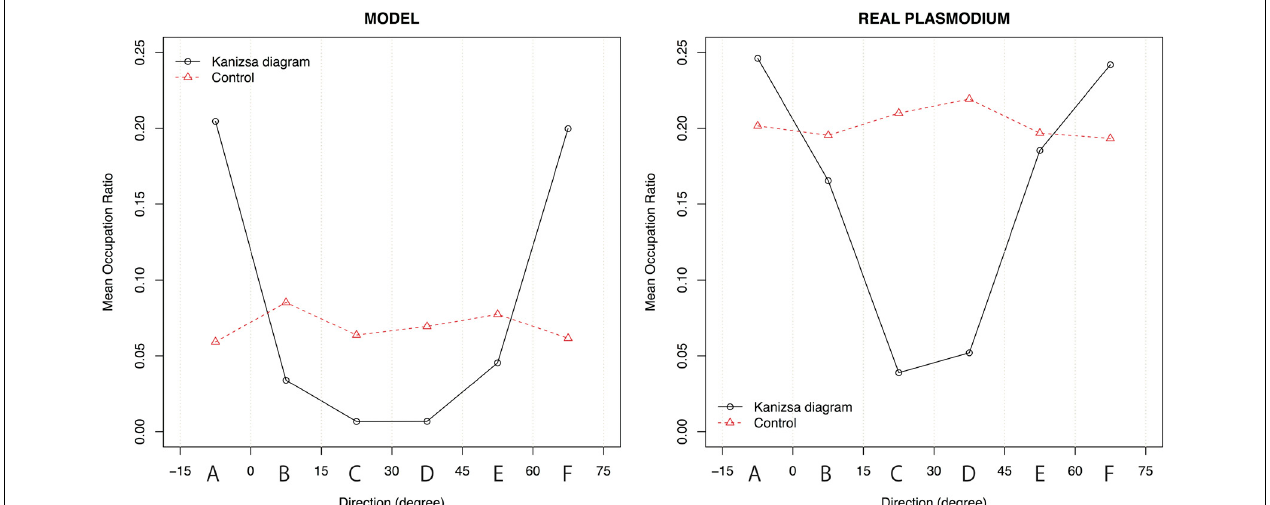
FIGURE 11 | The relationship between the mean value of the occupation ratio and direction. For the Kanizsa diagram, there are two peaks at region A and F in both experiments. In the model case, type I and type III networks